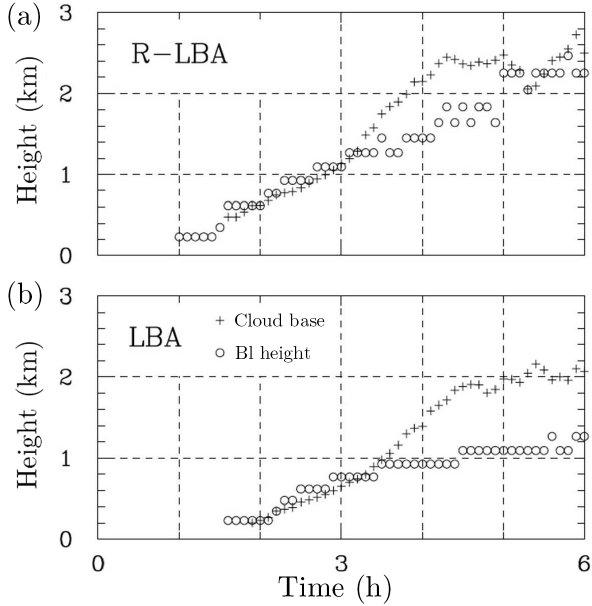
boundary layer height (circles) in R-LBA (a) and LBA (b) simu- lations. Dashed lines are included to highlight differences between the